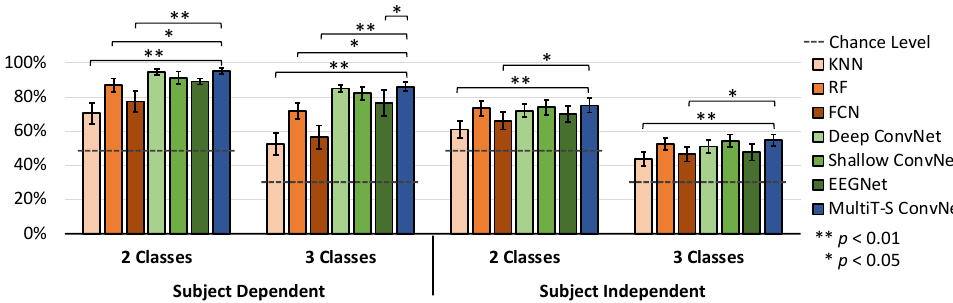
Figure 7. Average classification accuracy for all subjects on the SEED dataset. Error bars denote a 95% confidence interval (CI) computed from all subject’s means. The horizontal dashed lines indicate the chance level. The stars indicate significant differences compared with MultiT-S ConvNet. Table 1. The accuracy results of subject-dependent and subject-independent classification on SEED and DEAP datasets. The bottom row indicates our proposed MultiT-S ConvNet results. Bold indicates the highest